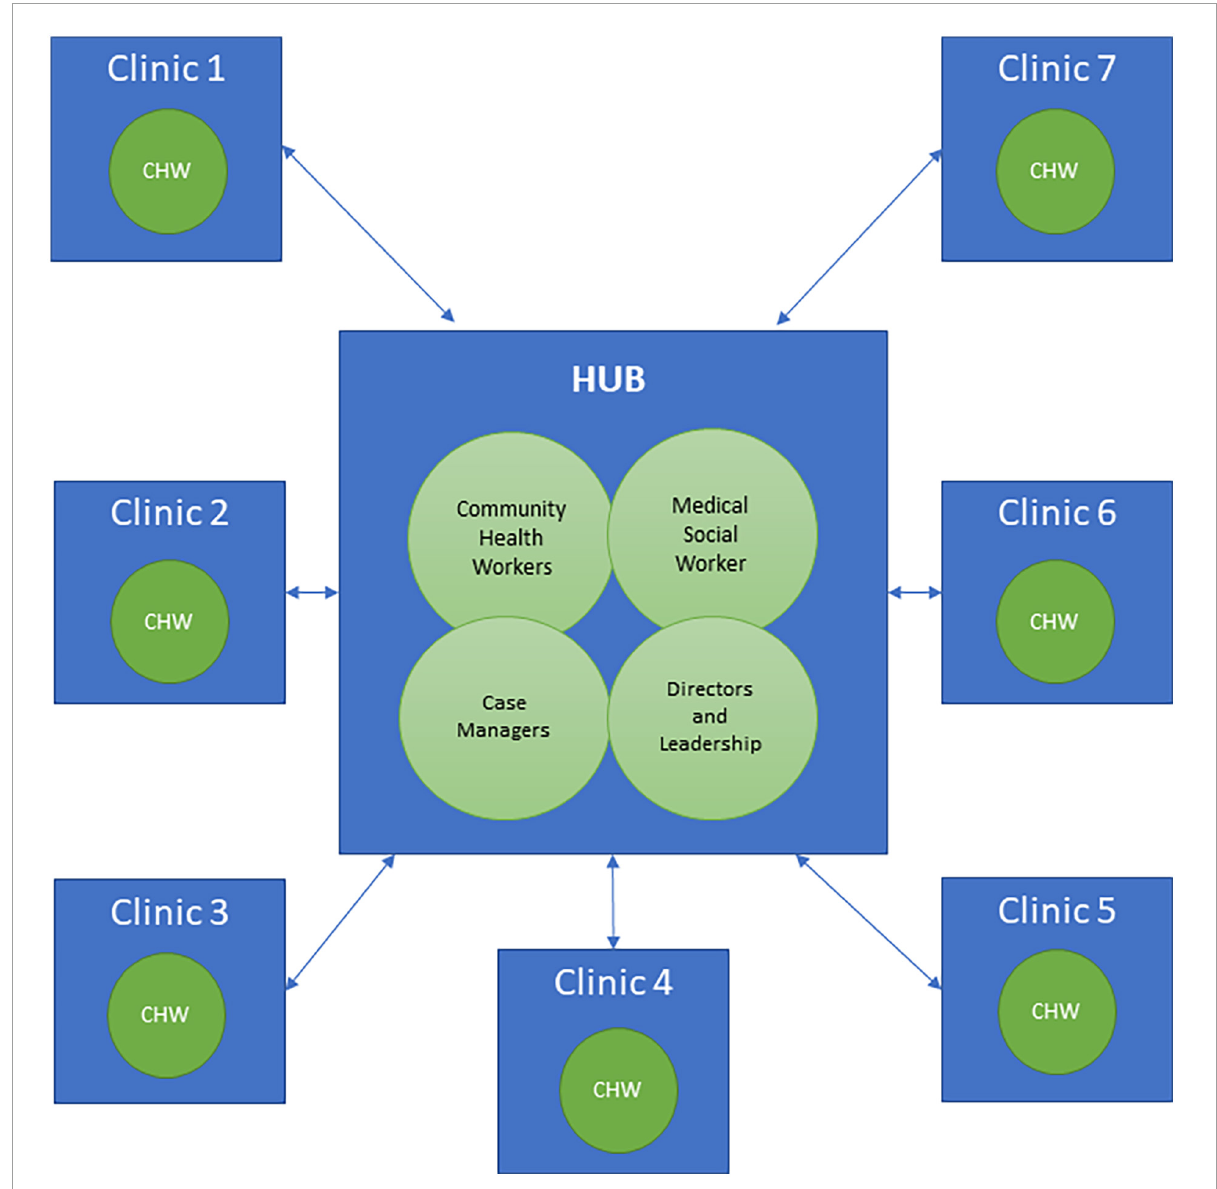
FIGURE1 Centralized hub’s relationship with clinics and staff in the academic practice